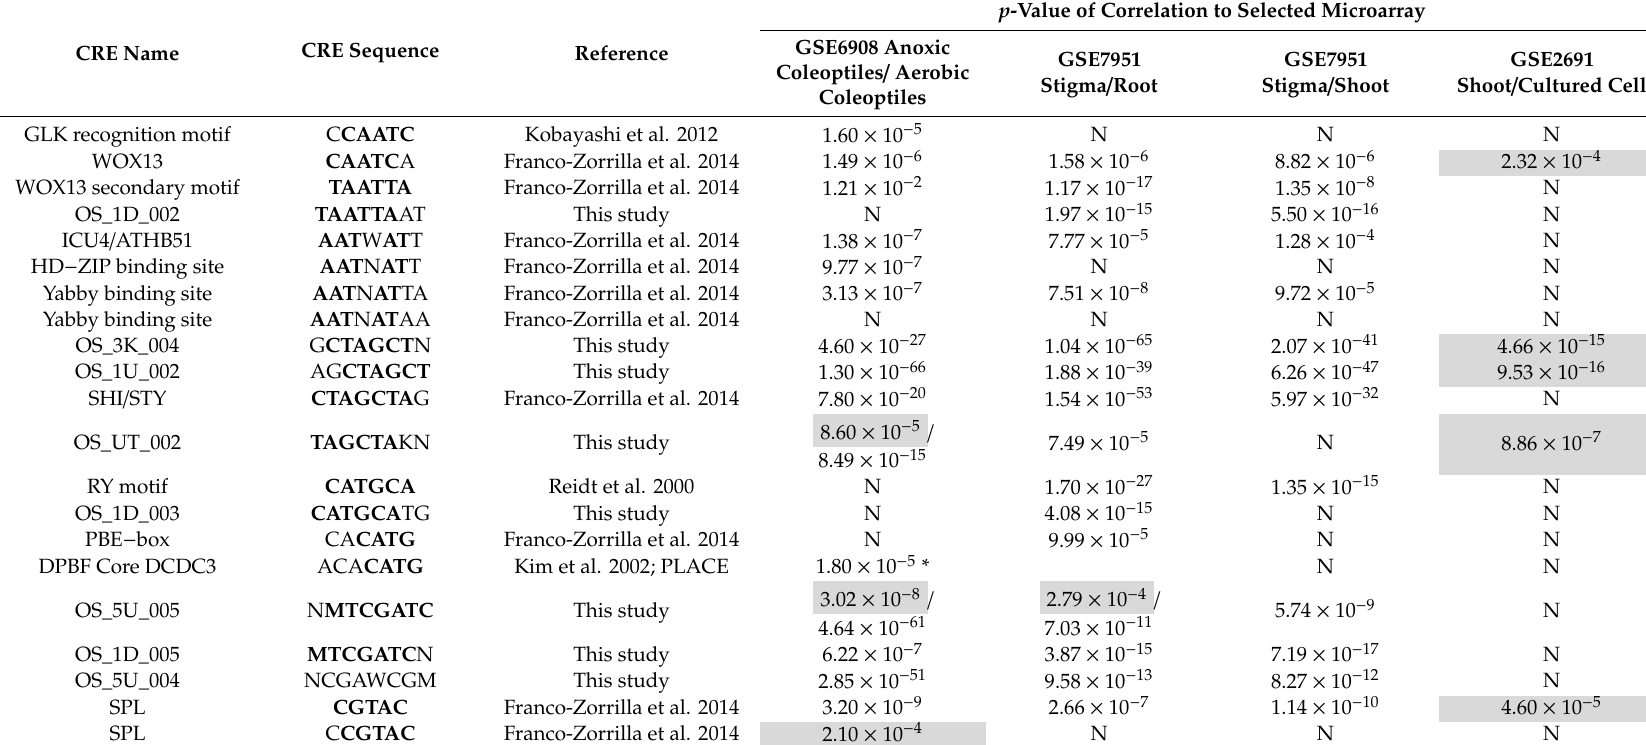
Table 3. CREs with contrasting regulation to